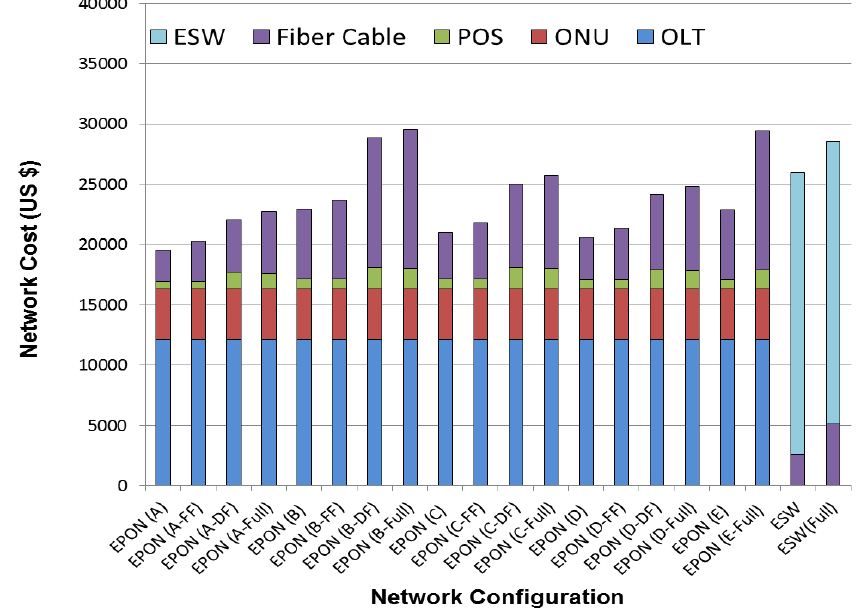
Figure 14. Network cost for WPF architectures.